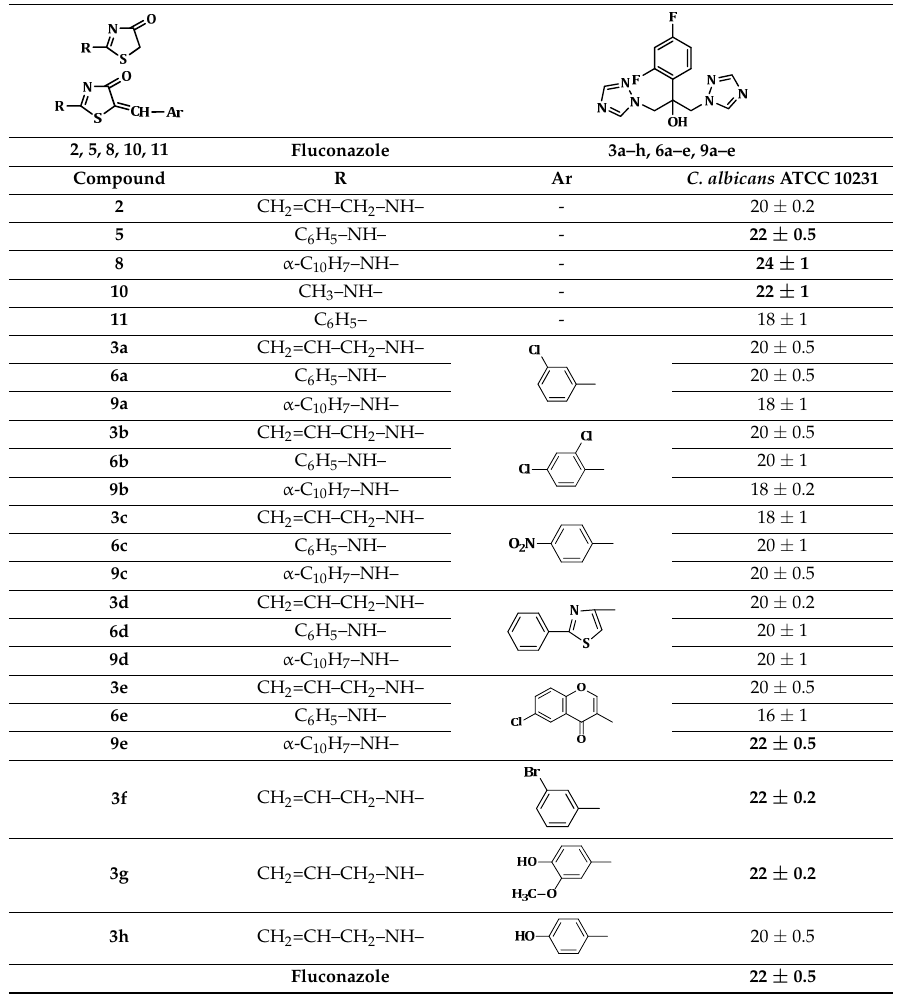
Table 1. Table 1. The antifungal activity of the synthesized thiazolin-4-one derivatives (inhibition zone Table 1. The antifungal activity of the synthesized thiazolin-4-one derivatives (inhibition zone Table 1. The antifungal activity of the synthesized thiazolin-4-one derivatives (inhibition zone diameters (mm)). diameters (mm)). diameters (mm)). Table 1. The antifungal activity of the synthesized thiazolin-4-one derivatives (inhibition zone diameters (mm)). Table 1. The antifungal activity of the synthesized thiazolin-4-one derivatives (inhibition zone diameters (mm)). Table 1. The antifungal activity of the synthesized thiazolin-4-one derivatives (inhibition zone diameters (mm)). Table 1. The antifungal activity of the synthesized thiazolin-4-one derivatives (inhibition zone diameters (mm)). Table 1. The antifungal activity of the synthesized thiazolin-4-one derivatives (inhibition zone Table 1. The antifungal activity of the synthesized thiazolin-4-one derivatives (inhibition zone diameters (mm)). Table 1. The antifungal activity of the synthesized thiazolin-4-one derivatives (inhibition zone Table 1. The antifungal activity of the synthesized thiazolin-4-one derivatives (inhibition zone diameters (mm)). diameters (mm)). diameters